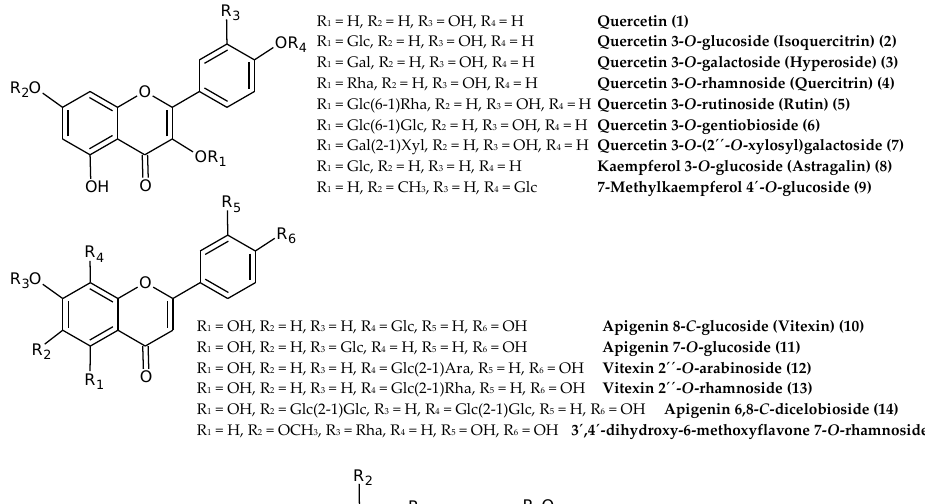
Flavonoids and Procyanidins